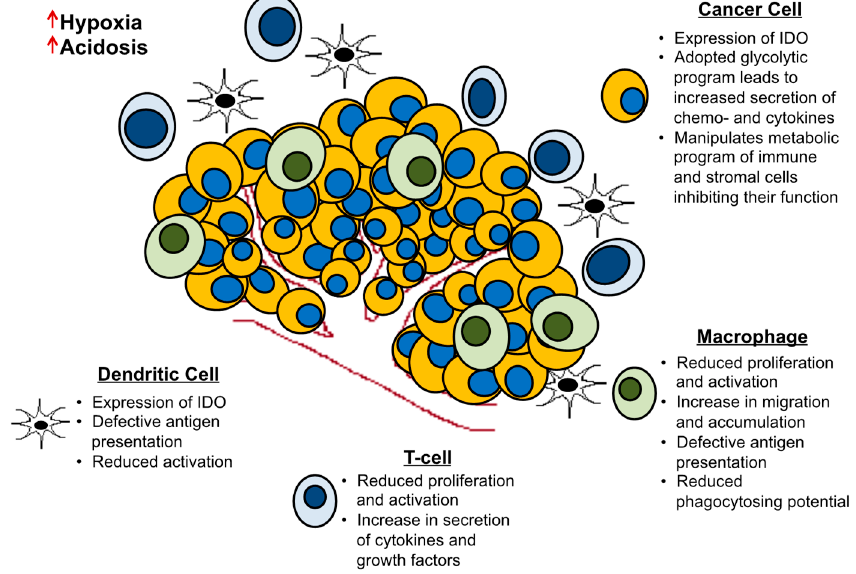
Figure 2. Metabolic interactions between the tumor and its microenvironment. T-cells, dendritic cells, and macrophages undergo metabolic reprogramming with different functional consequences (noted in the figure) that often propel tumor growth and